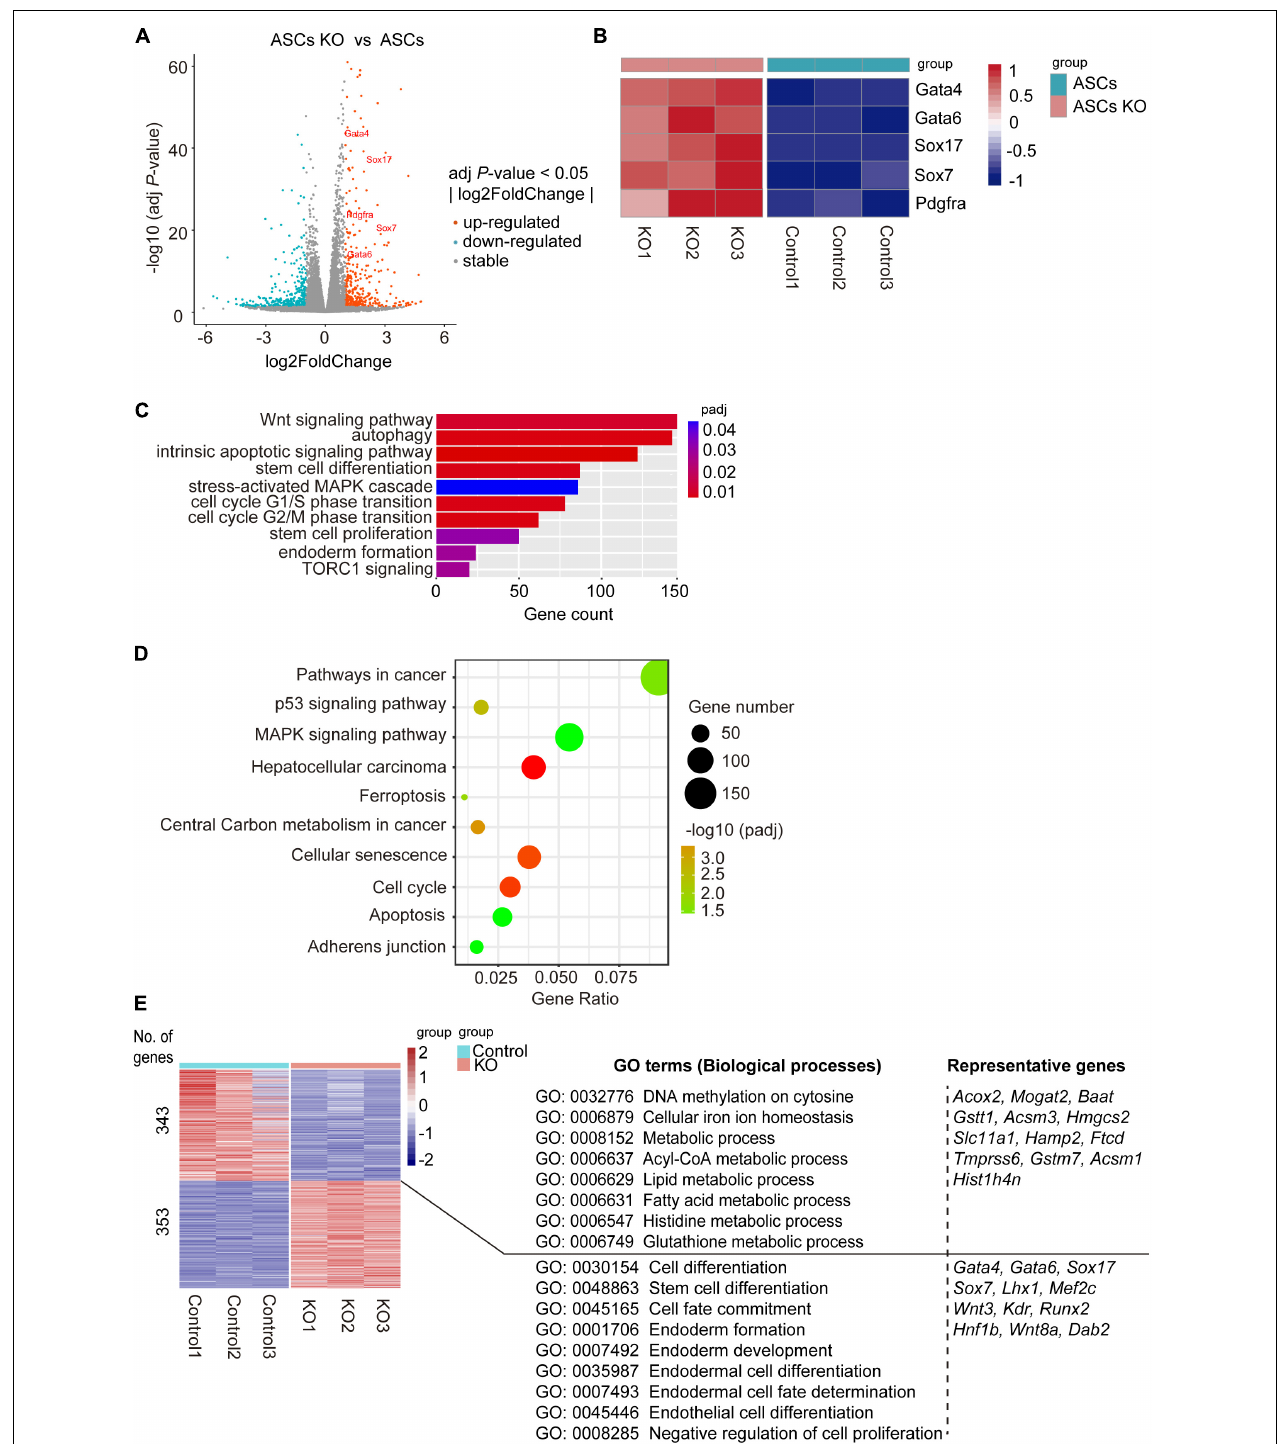
FIGURE 3 | Analysis of molecular features of Bdh2 -knockout ASCs. (A) Volcano plot of differentially expressed genes for Bdh2 -knockout ASCs versus ASCs. (B) Heatmap showing scaled expression of endoderm-associated genes. (C) Gene Ontology (GO) analysis of significantly enriched “biological processes” (BP) of the differentially expressed genes (DEGs) for Bdh2 -knockout ASCs versus ASCs described in (A) . (D) Kyoto Encyclopedia of Genes and Genomes (KEGG) pathway analysis of DEGs for Bdh2 -knockout ASCs versus ASCs described in (A) . (E) Heatmap showing scaled expression values of a total of 696 DEGs [mean log2 (normalized read counts) > 2, log2 (fold change) ≥ 1, adjusted p value < 0.05] in Bdh2 -knockout ASCs versus ASCs. Significantly enriched GO terms and representative genes in each cluster are listed on the right.